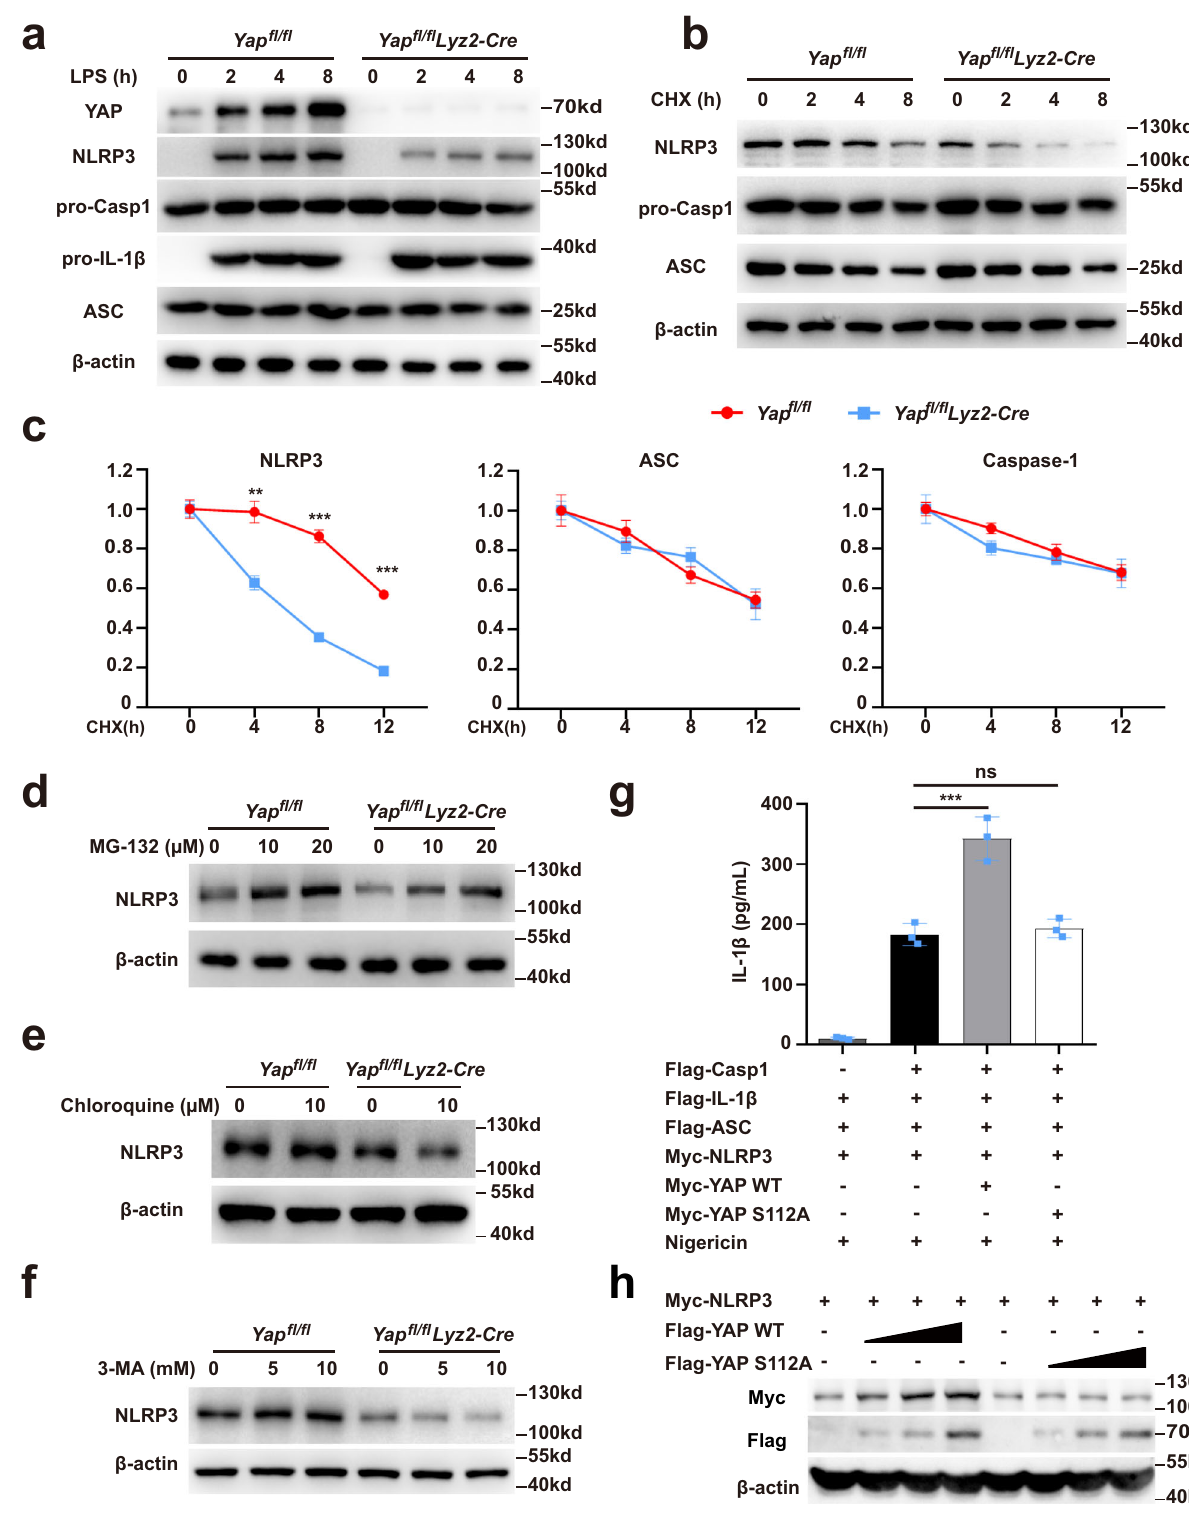
K27-linked polyubiquitination of NLRP3 but had no appreciable effect on the NLRP3 ubiquitination of other types of